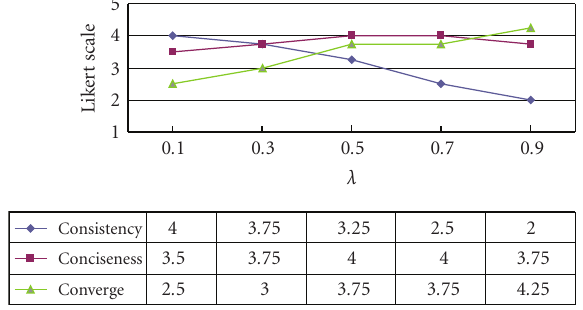
Figure 12: User evaluation of personalized video customization.